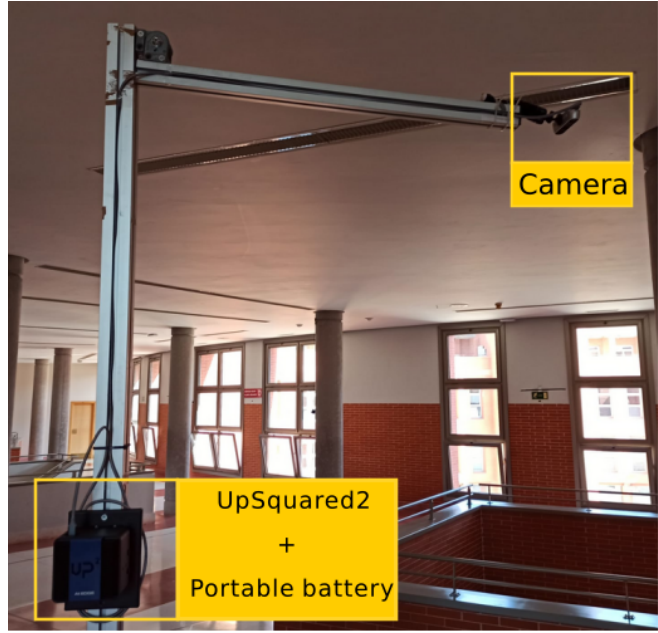
Figure 9. Mounted test system.